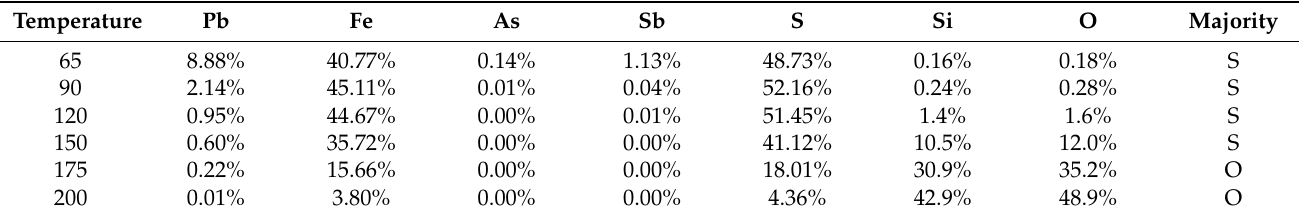
Table 13. Results for initial kinetics model with first set of minerals in weight percentage.